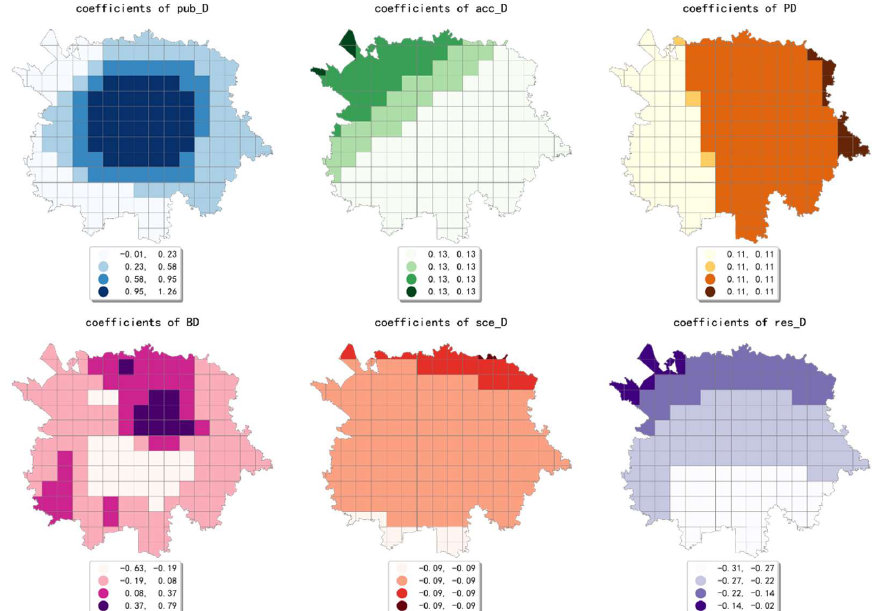
Int. J. Environ. Res. Public Health 2022 , 19 , x FOR PEER REVIEW Figure 6. The estimated coefficient maps in the grid with 2500 m. Figure 6. The estimated coefficient maps in the grid with 2500 m.